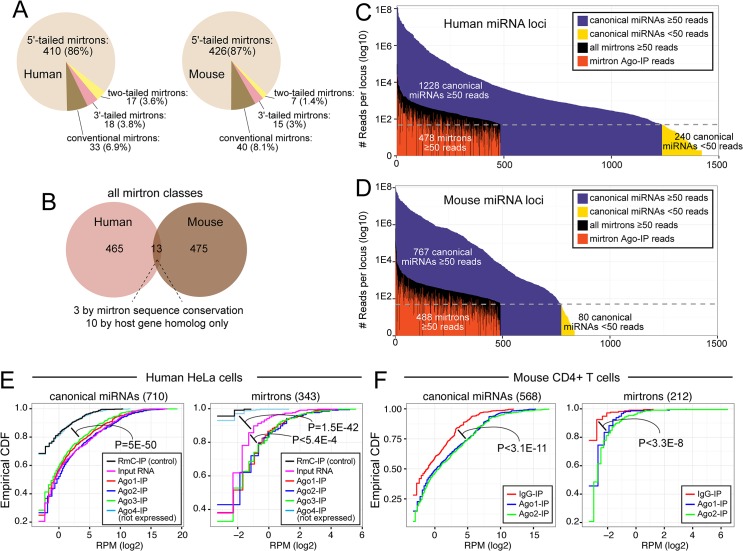
Greatly expanded annotations of human and mouse mirtrons.(A) Numbers of splicing-derived miRNAs in human and mouse, categorized as conventional, 5'-tailed, 3'-tailed, and two-tailed mirtrons. Most of the miRNAs newly annotated in this study were 5'-tailed mirtrons, reflecting their status as the dominant mirtron class in human and mouse. (B) Few mirtrons were annotated from small RNA data in both mouse and human, and only a subset of these were constrained in primary sequence. (C, D) Human and mouse mirtrons are generally modestly expressed, but were annotated to higher levels of evidence than hundreds of human and mouse miRNAs in the miRBase registry (i.e. that have <50 reads in the aggregate data analyzed in this study). Most mirtrons were supported by evidence from Ago-IP datasets (red bars). (E, F) Cumulative distribution function (CDF) plots of enrichment of canonical miRNAs and mirtron-derived miRNAs in Ago complexes. (E) Analysis of human small RNAs. Rat RmC was used as control IP; since Ago4 is not expressed in HeLa cells, it effectively serves as another control IP. Canonical miRNAs were enriched in Ago1-3-IP data as well as input RNA (which is mostly composed of Ago-bound miRNAs), relative to control IP data. Mirtron-derived small RNAs showed similar Ago-IP enrichment, except that they also exhibited enrichment between Ago1-3-IP and input RNA libraries. (F) Analysis of mouse small RNAs shows similar enrichment of canonical miRNAs and mirtron-derived small RNAs in Ago1 and Ago2 complexes relative to control IgG complex.